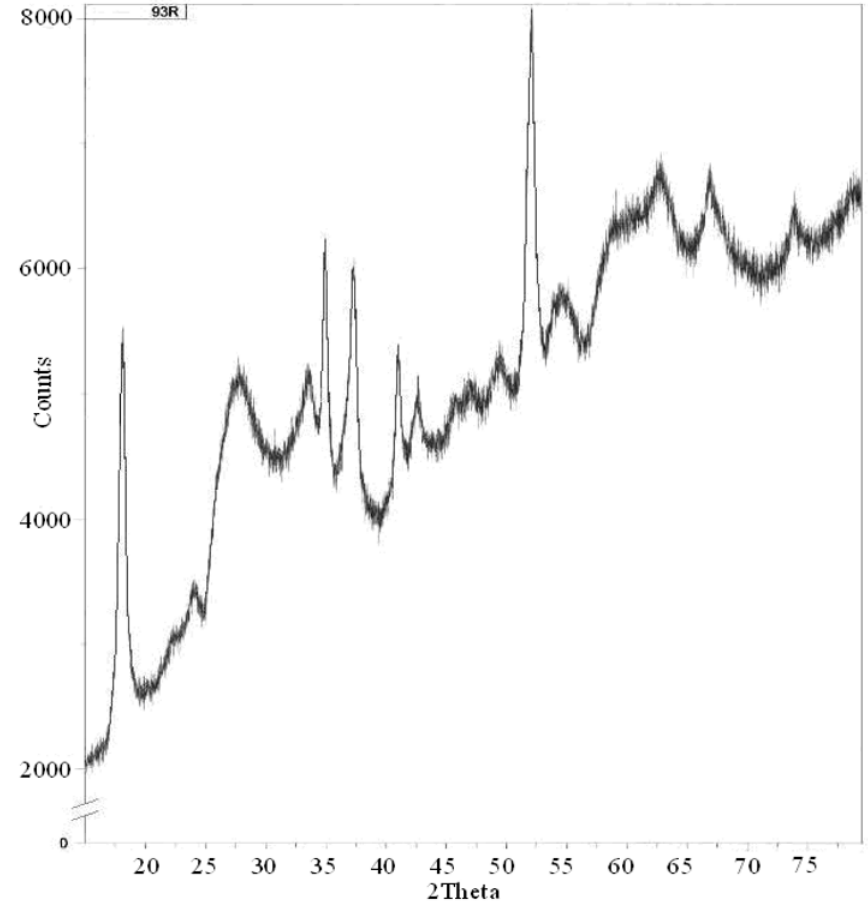
Figure 5. XRD pattern of MnWO